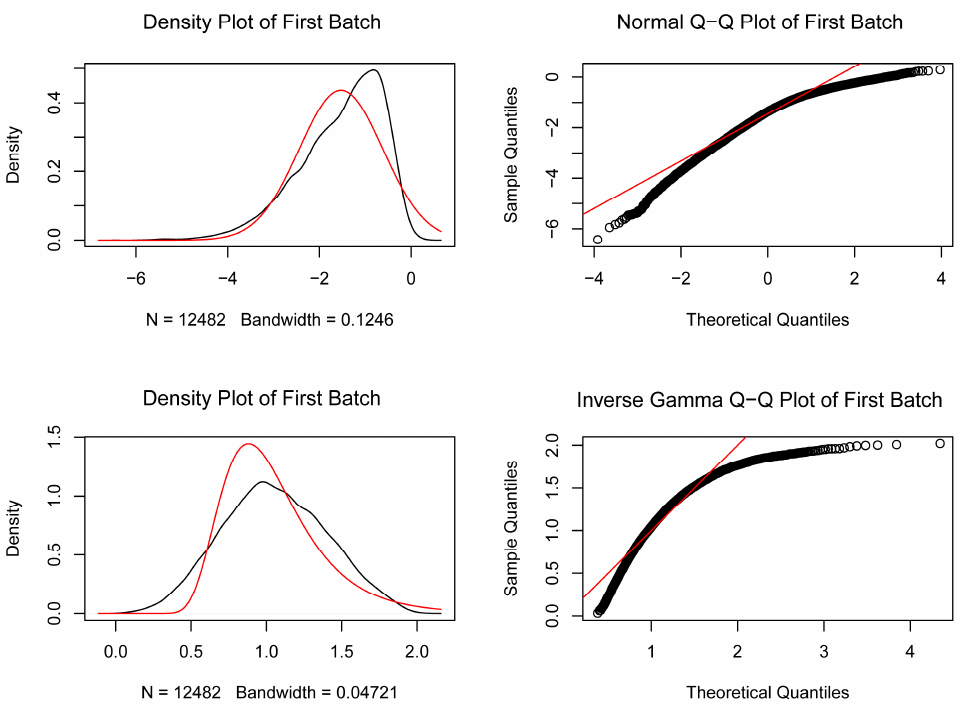
Figure 1. The quantile–quantile (Q-Q) plot of the inter-batch di ff erence of GSE55235 and GSE55457 datasets is removed. The red line represents the density map of the GSE55235 data distribution, the black line represents the density map of the GSE55457 data distribution, and the black circles represent the quantiles corresponding to the same cumulative